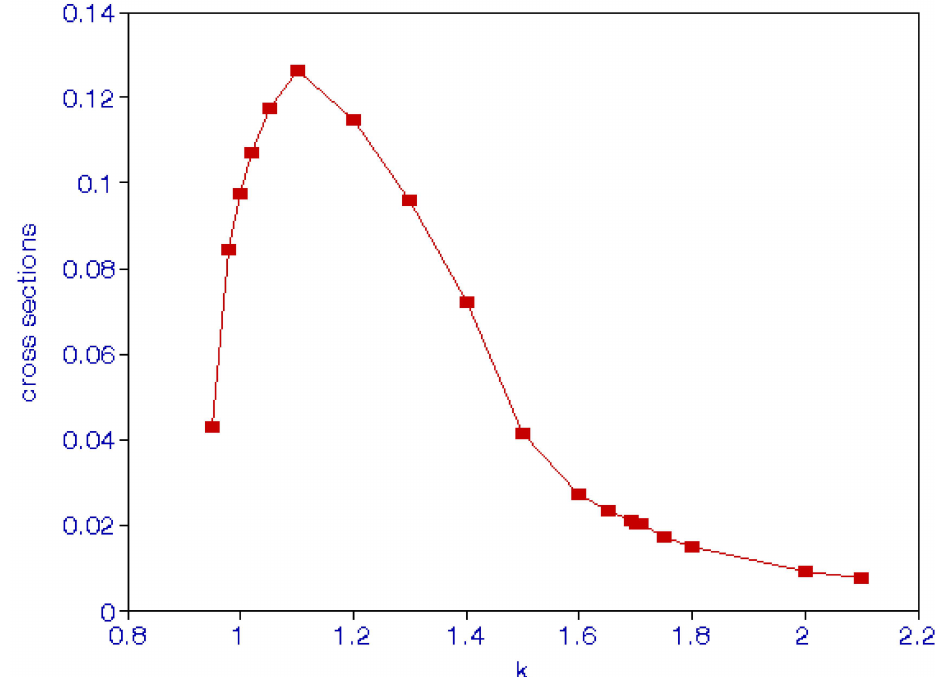
Figure 1. (Color online) Total 1 S to 2 S excitation cross sections ( π a 2 k (Ryd).